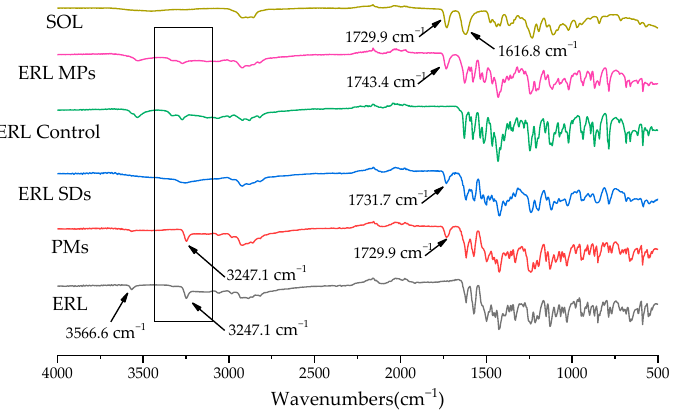
Figure 7. FT-IR spectra of ERL, PMs, ERL SDs, ERL control, ERL MPs and SOL from 4000 to 400 cm − 1 .